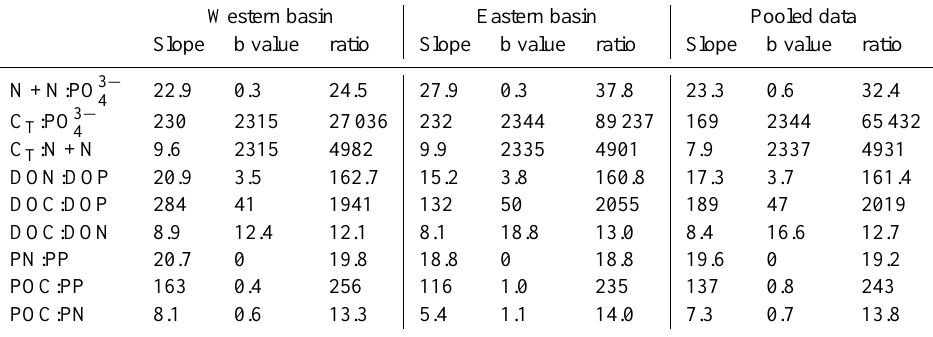
Table 3. C:N:P stoichiometry expressed as the slope and the intercept (b value) of the element-element regression line and the average ratio of measured concentrations in the western and eastern basins of the Mediterranean Sea and for pooled data during the BOUM cruise. To avoid infinitive ratios, we excluded data with concentration below the detection limit. N+N is used for NO − Western basin Eastern basin Pooled